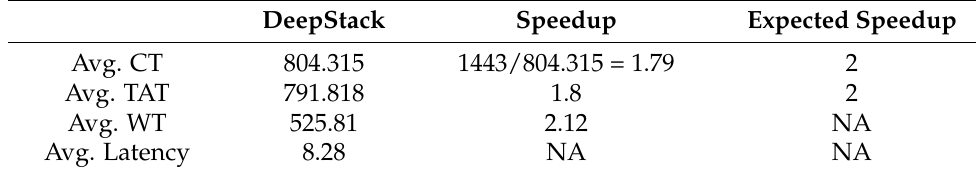
Table 7. Torque job execution order on 2-node cluster.